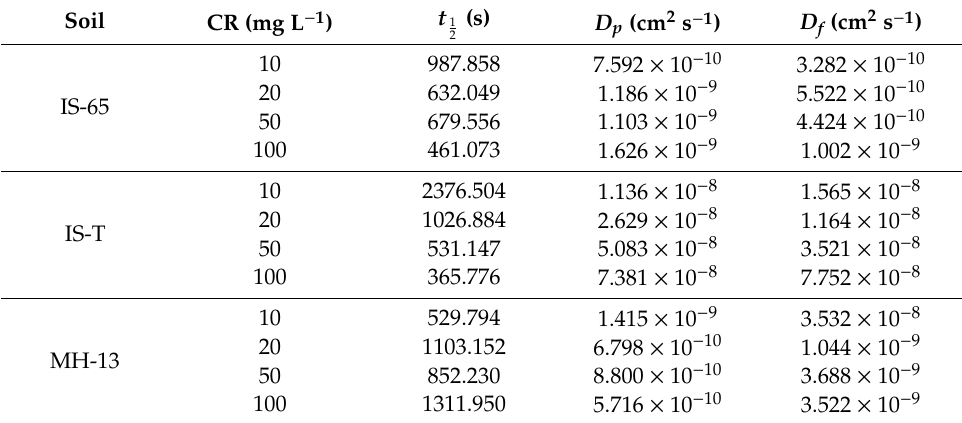
Table 7. Pore di ff usion ( D p ) and film di ff usion ( D f ) coe ffi cients for CR sorption on